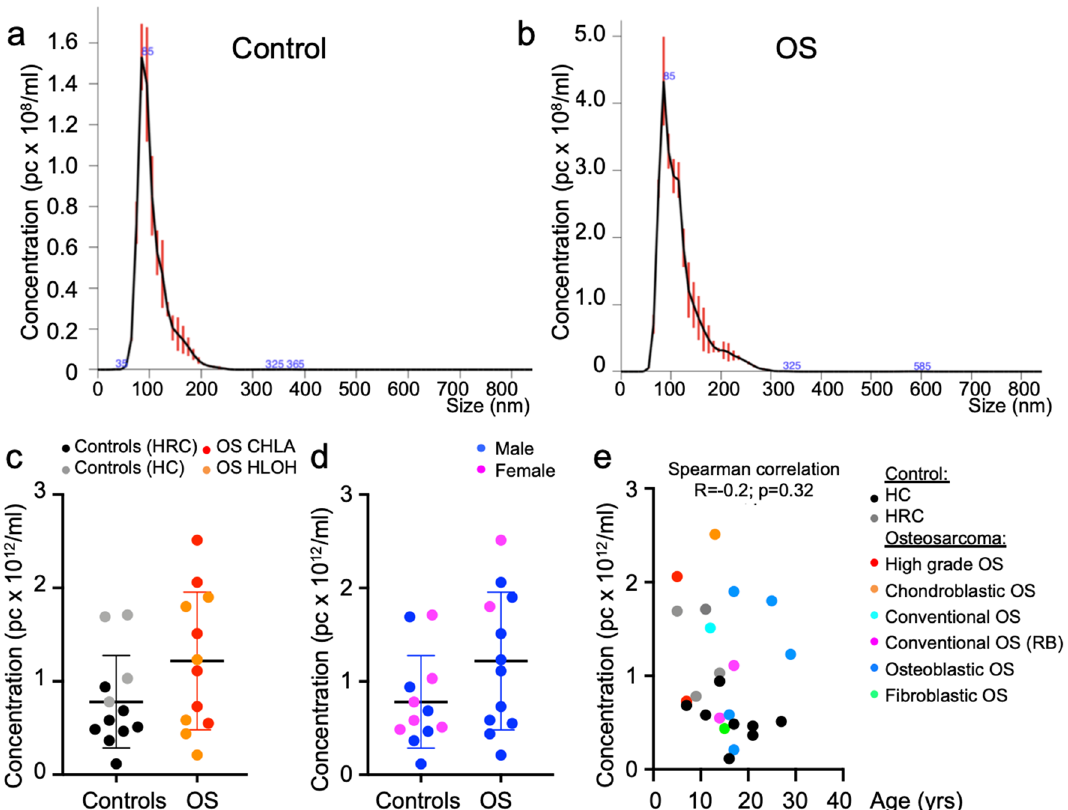
Figure 1. Patient EV preparation characteristics. ( a , b ) Representative control ( a ) and OS ( b ) particle size distributions in preparations used for nucleic acid extraction and sequencing, as defined by nanoparticle tracking (NanoSight). ( c , d ) Dot plots representing EV concentration of preparations from sera of OS patients (n = 12) and controls from hereditary retinoblastoma sibling (HRC, n = 4), and unrelated healthy (HC, n = 8) and color-coded by source ( c ) and sex ( d ). Lines represent mean and standard deviation. Groups were compared using two ‐ tailed, unpaired, Mann Whitney U test; * p < 0.05. ( e ) Dot plots of EV concentration versus donor age and color coded according to OS type. Spearman’s correlation (r) between EV concentration and donor age was not significant ( p =